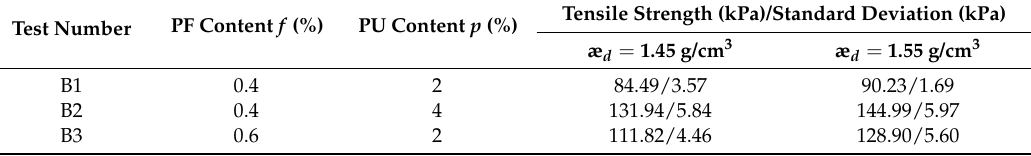
Table 5. Tensile strength of B1–B3 groups.